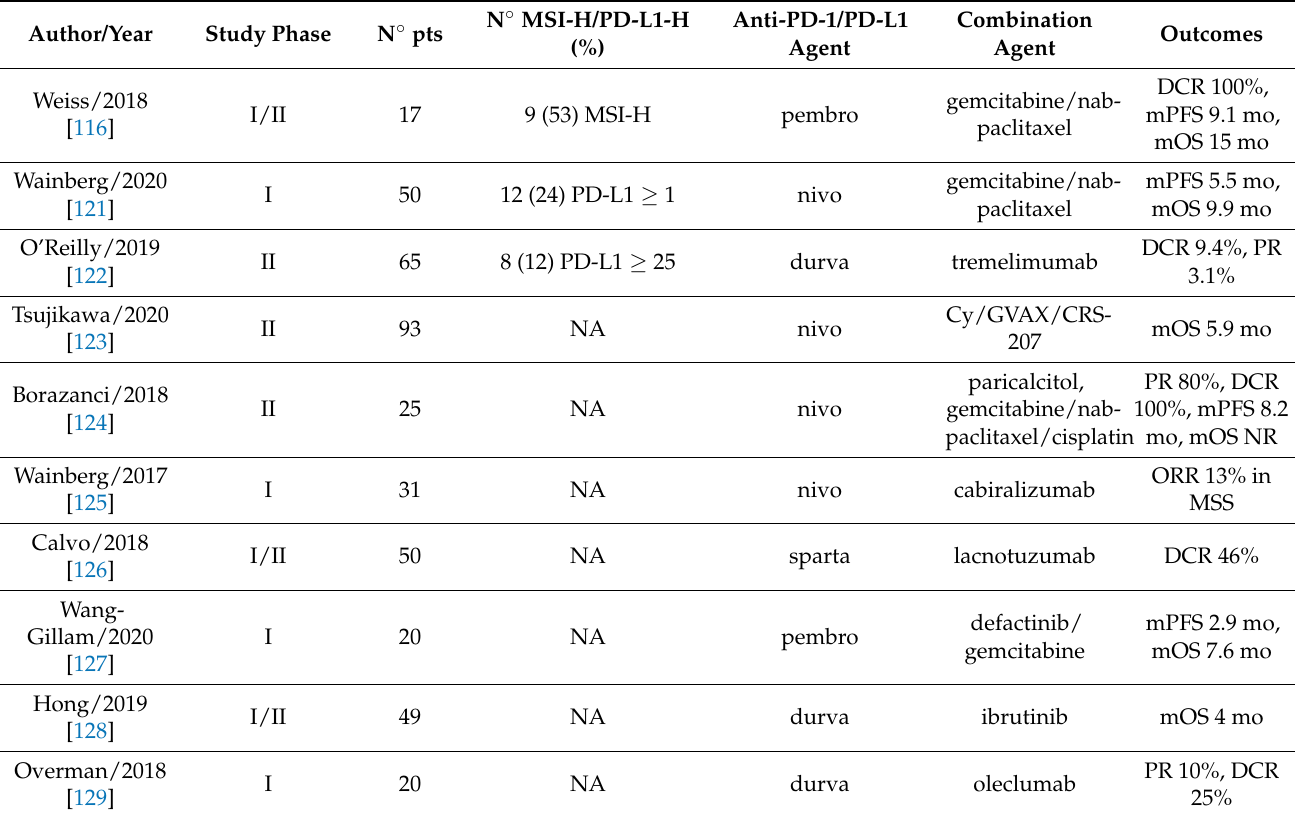
Table 2. Phase I/II studies involving anti-PD-1 and PD-L1 in metastatic pancreatic cancer.